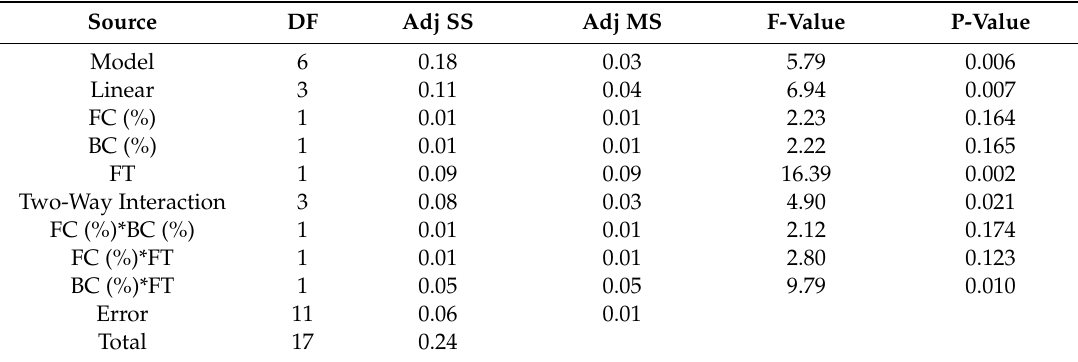
Figure 17. Comparison between JPS values obtained from multi-criteria decision-making analysis (MCDMA) and regression model. Table 13. Analysis of variance results for JPS.